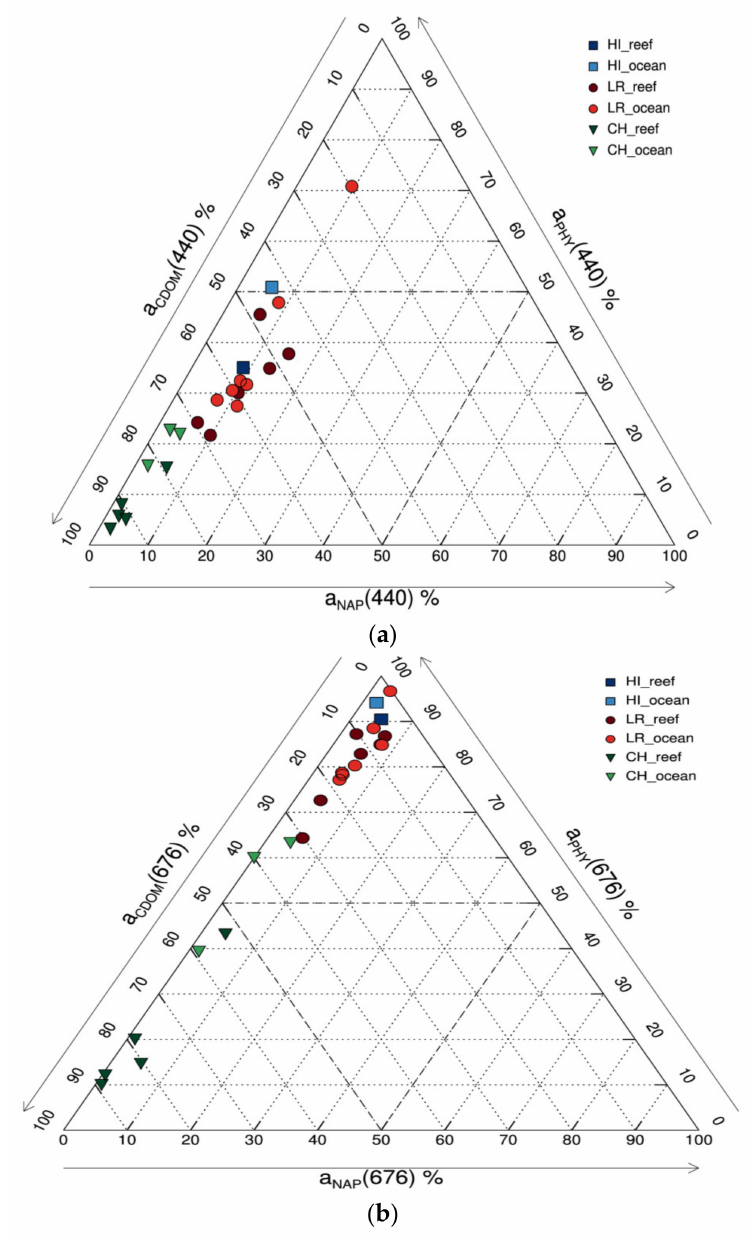
Figure 2. ( a ) The absorption budget at 440 nm (the % distribution of absorption at 440 nm by phyto- plankton, NAP and CDOM) for the Heron Island (HI), Lihou Reef (LR), and Coringa-Herald (CH) reef and ocean waters. Note that for Heron Island (HI), there was only one a( CDOM ) 440 measurement each for the reef and ocean waters. ( b ) The absorption budget at 676 nm (the % distribution of absorption at 676 nm by phytoplankton, NAP, and